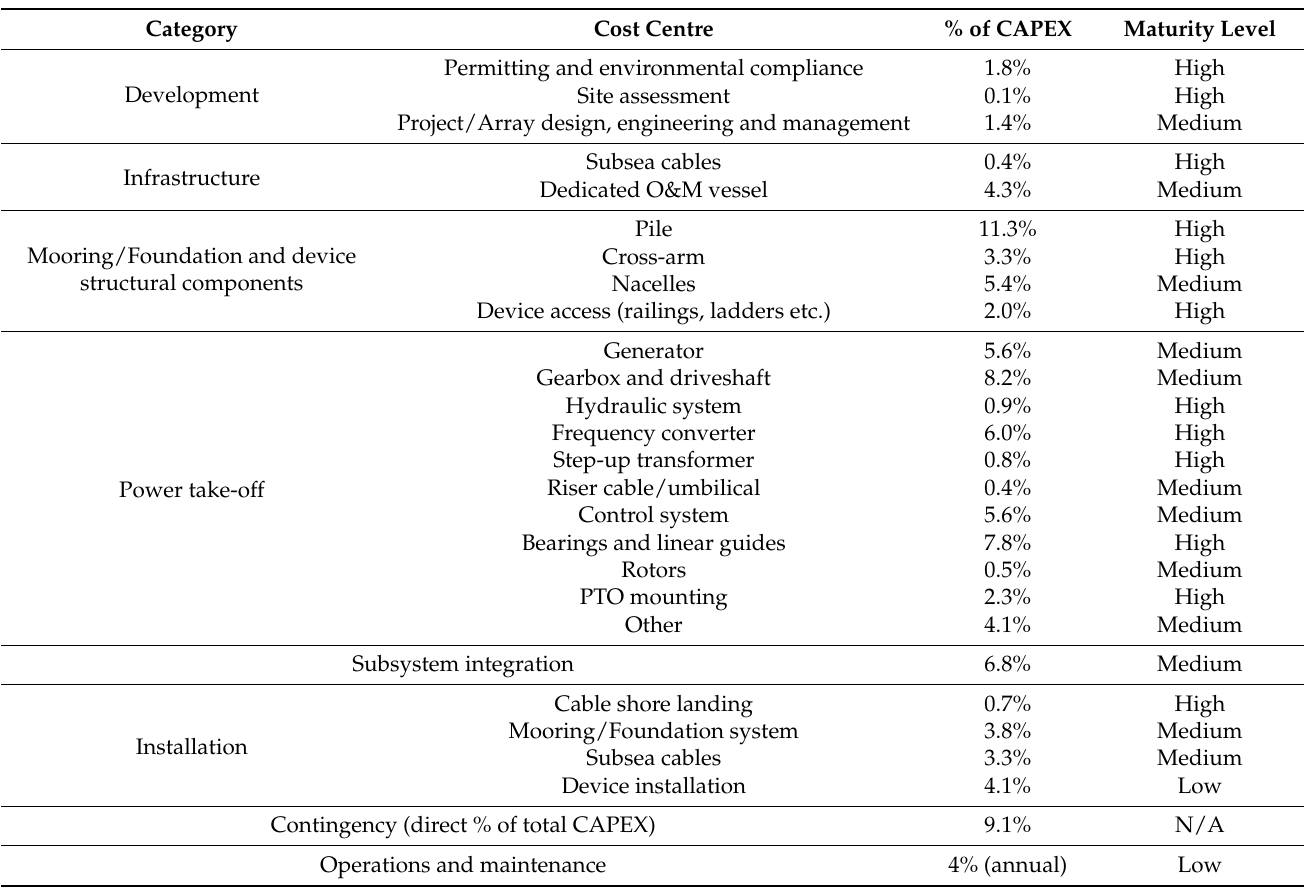
Table 6. Cost centre breakdown and corresponding component maturity levels assumed for tidal stream (bottom fixed), cost data based on [20].